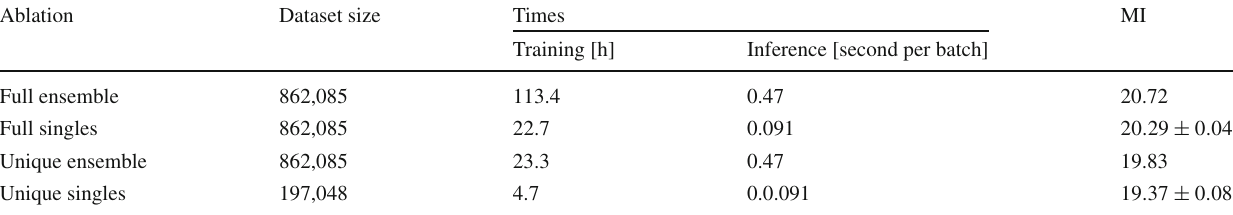
one fold of data. “Unique” indicates the model was trained on a unique set of seven folds of data, and monitored on one fold of data. In the case of the single models, the MI is averaged across five individual models